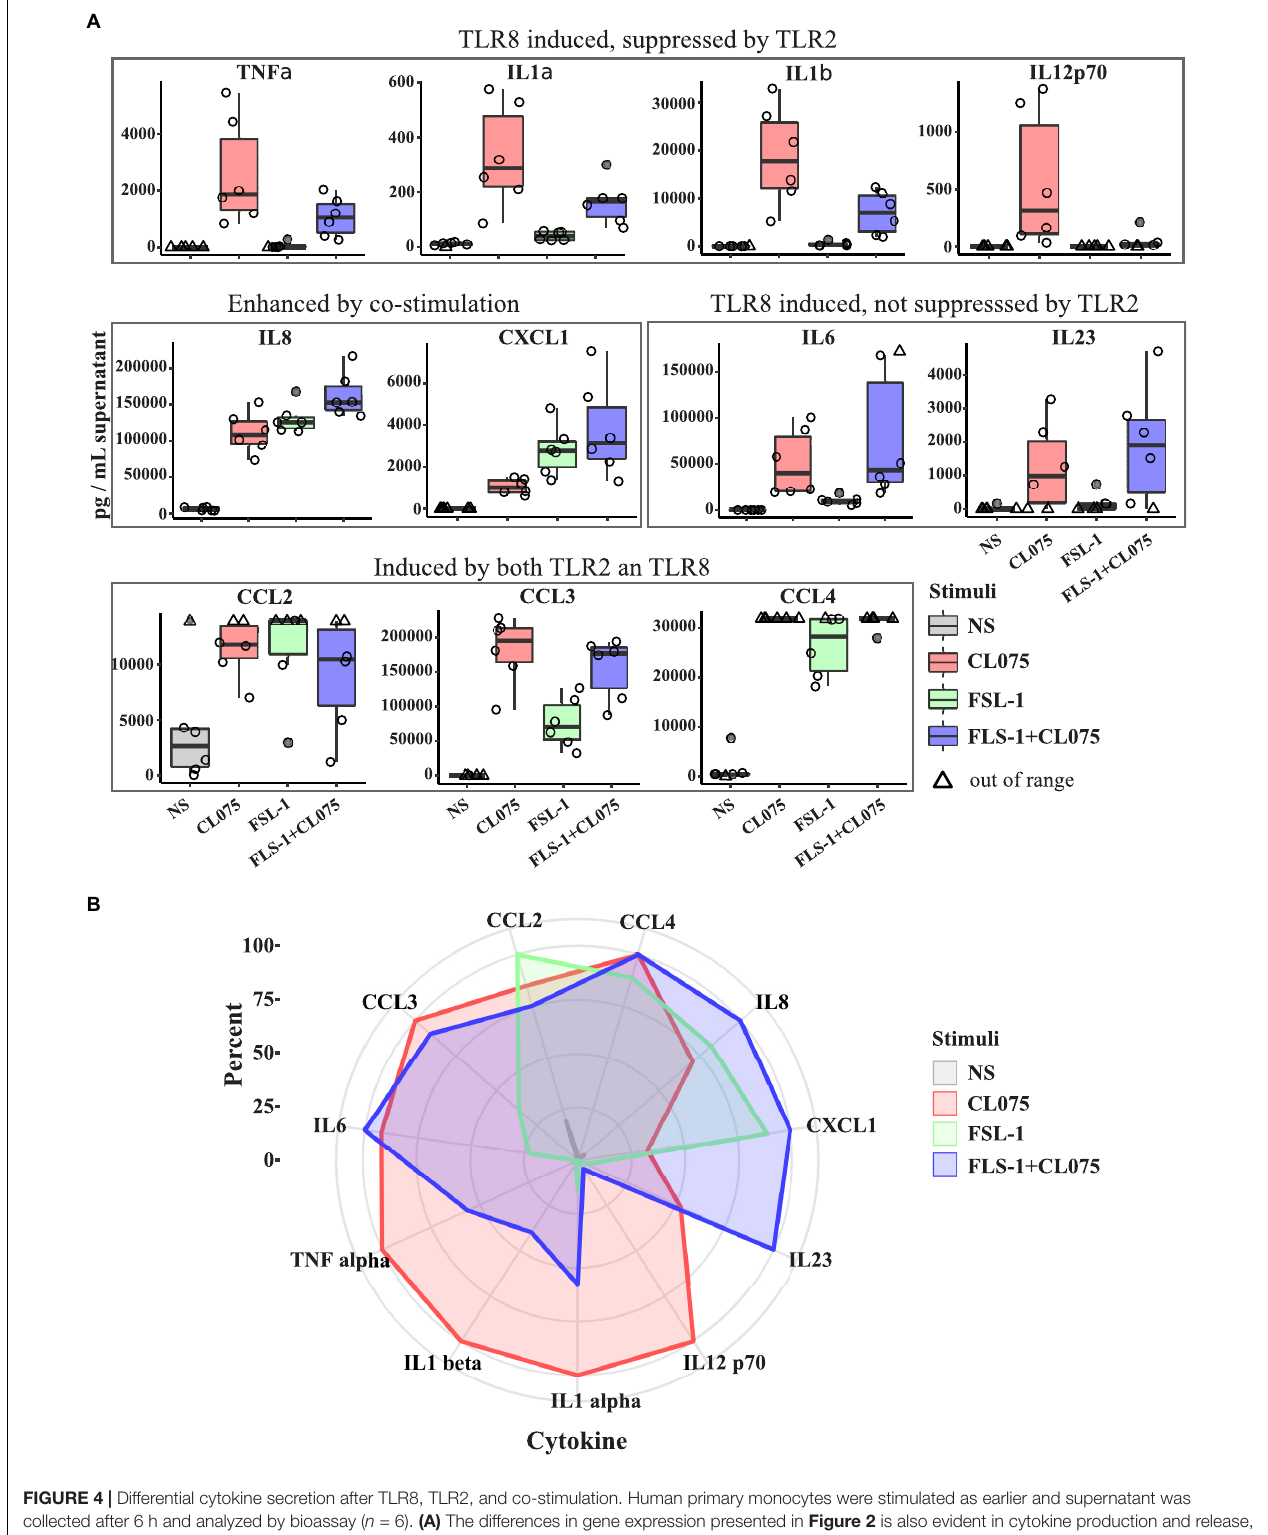
Frontiers in Physiology |